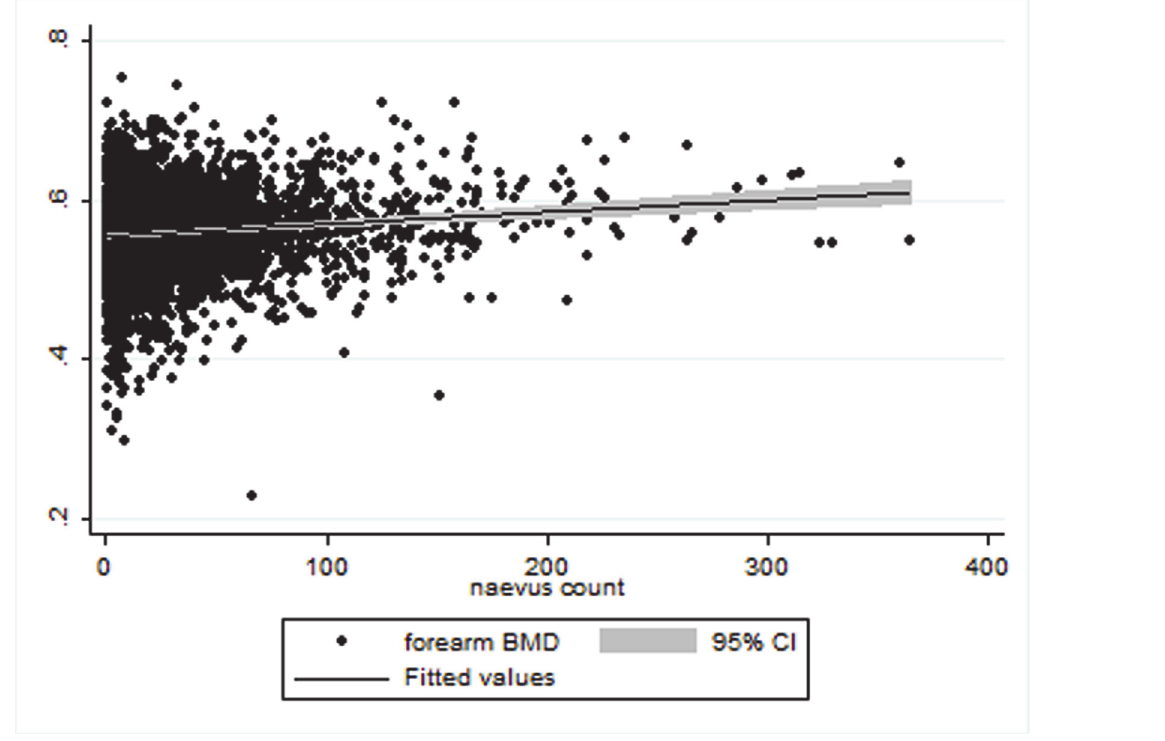
Figure 3. Scatter plot for Forearm BMD (Y axis) in association with naevus count (X